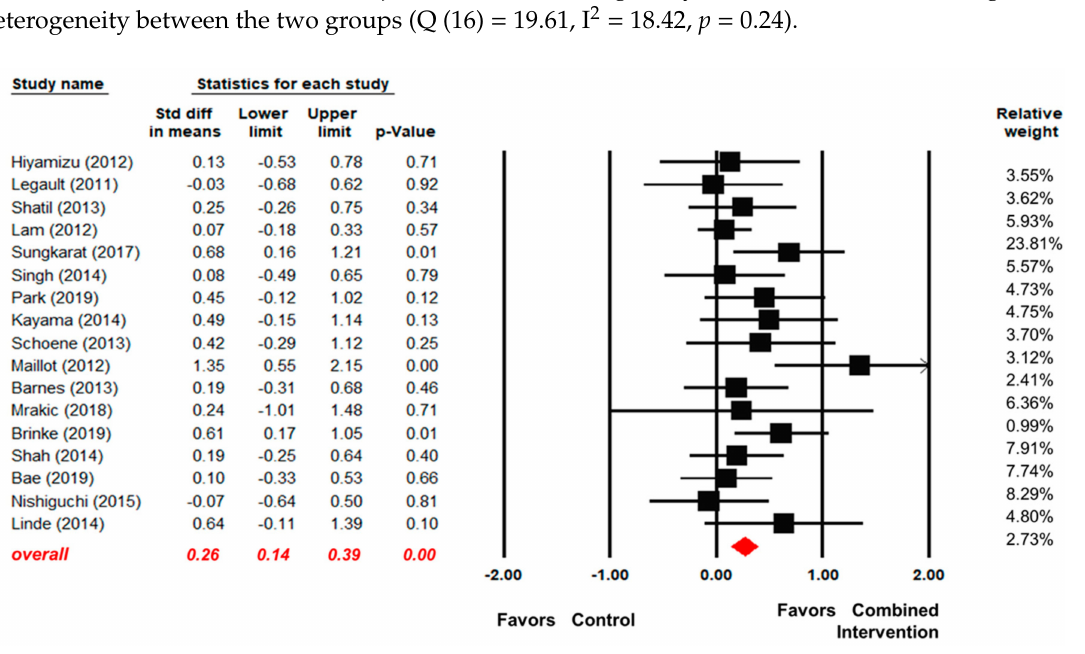
Figure 2. Forest plot for the e ff ect sizes of the combined interventions compared to the